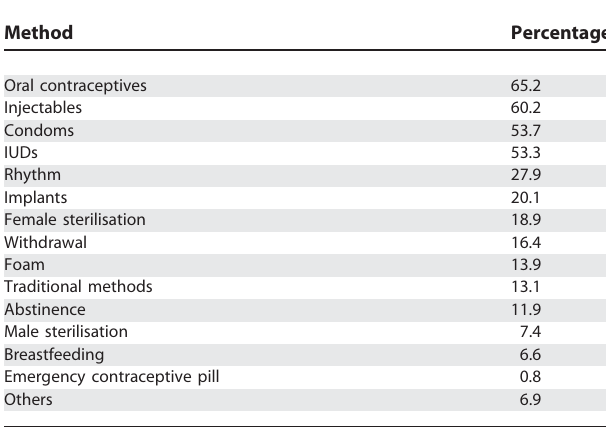
Table 1. Sources of Contraceptive Information among Sexually Active Respondents Source Percentage Friend